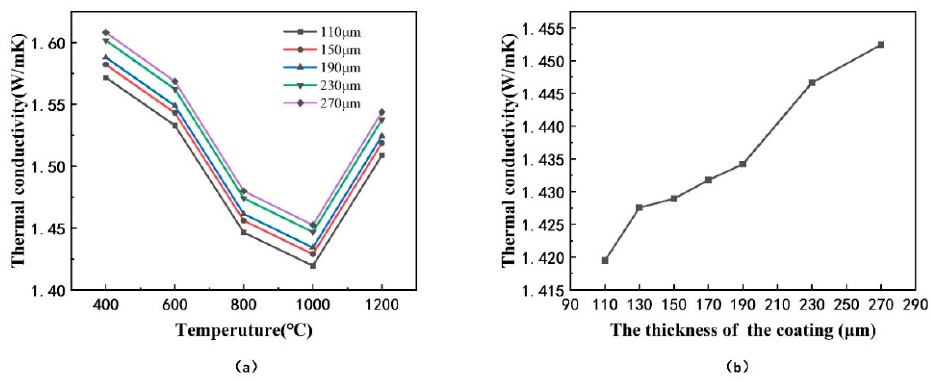
Figure 8. Coating models with different thickness of coatings.